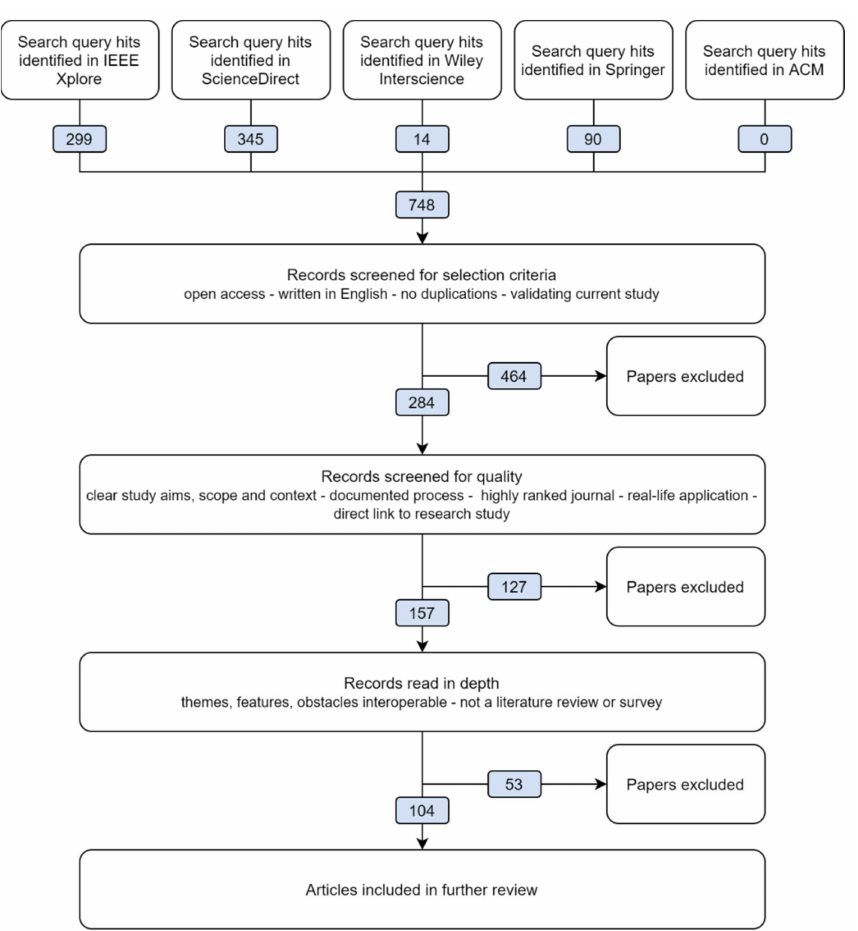
Figure 1. Flowchart of methodology applied during article processing. Modification from [36].